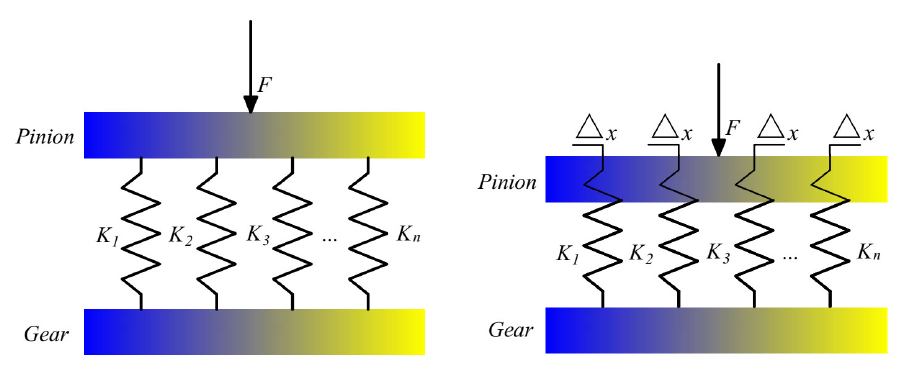
Figure 5. Load sharing model of the gear pair.